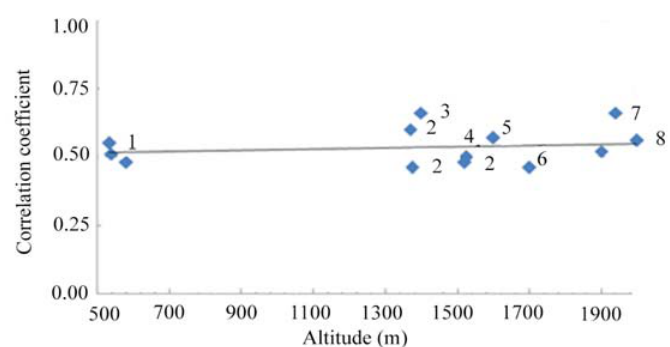
Fig. 5: Correlation between PCAB MXD series and IUVB depending on the altitude